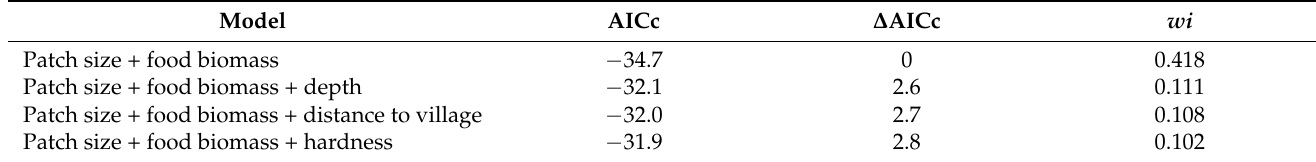
Figure 3. Spatio-temporal distribution of Hooded Cranes population in different wintering periods. ( a – c ) at Caizi Lakes and ( d – f ) at Shengjin Lake, presented the crane individuals in the kilometer grids in the early, middle, and late wintering periods. Table 1. Model selection-related relative abundance to variables using ∆